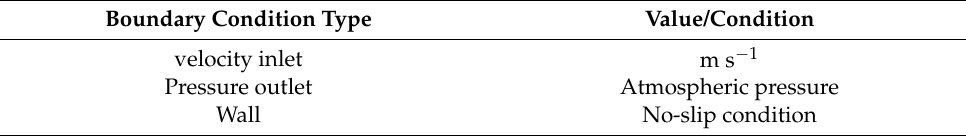
Table 2. Boundary conditions.